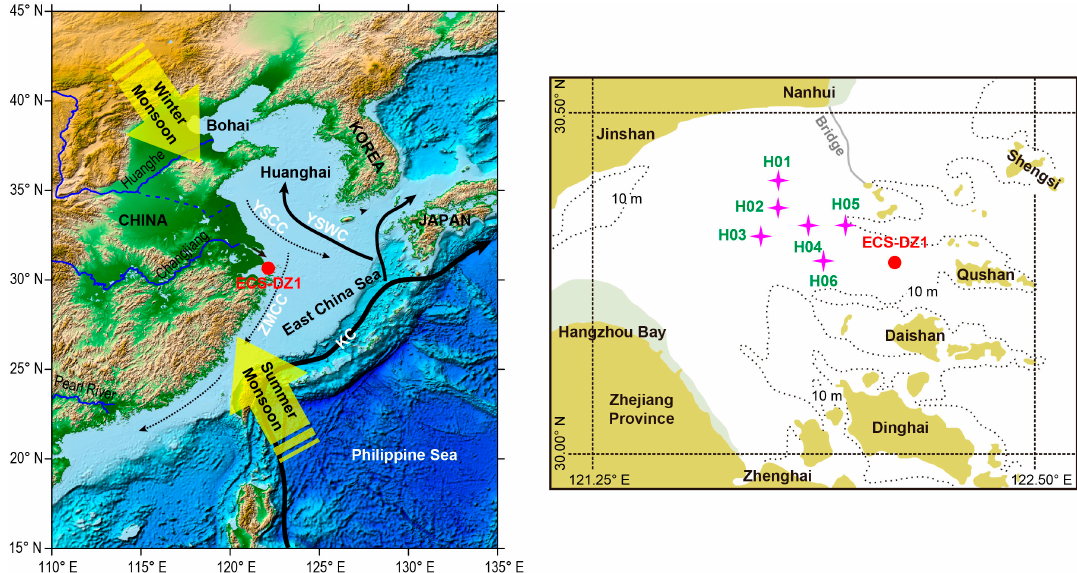
Figure 1. Location of core ECS-DZ1 with 6 sites of surface samples (H1-H6) and regional climatic and oceanographic systems. The solid arrows denote warm currents (YSWC, Yellow Sea warm current; KC, Kuroshio current), and the dashed arrows indicate coastal cold waters (YSCC, Yellow Sea coast cold water). The base map data was generated using the open and free software DIVA-GIS 7.5 (http://www.diva-gis.org/).